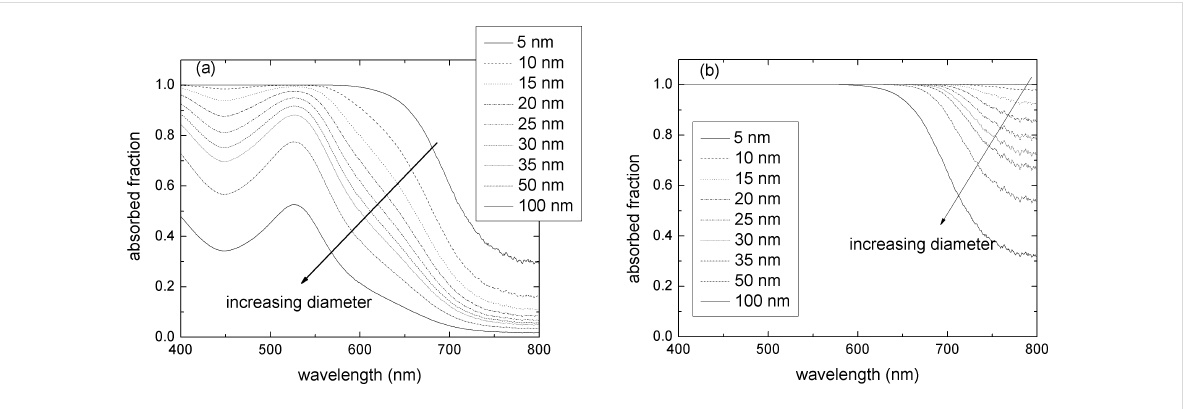
Figure 5: Fraction of light absorbed in the modeled PA in absence of light trapping (a), and in the case of maximum light trapping (b), shown for different diameters of titania nanoparticles.